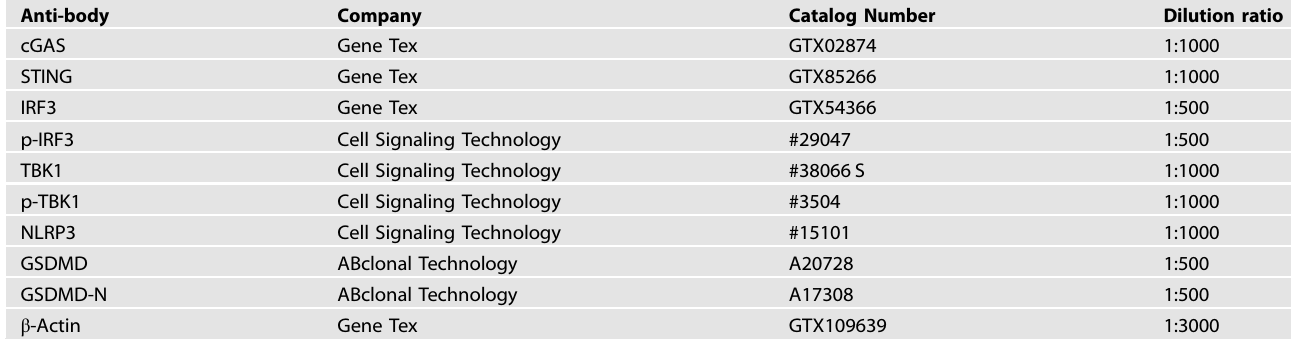
Table 1. Antibodies for western blot. Anti-body